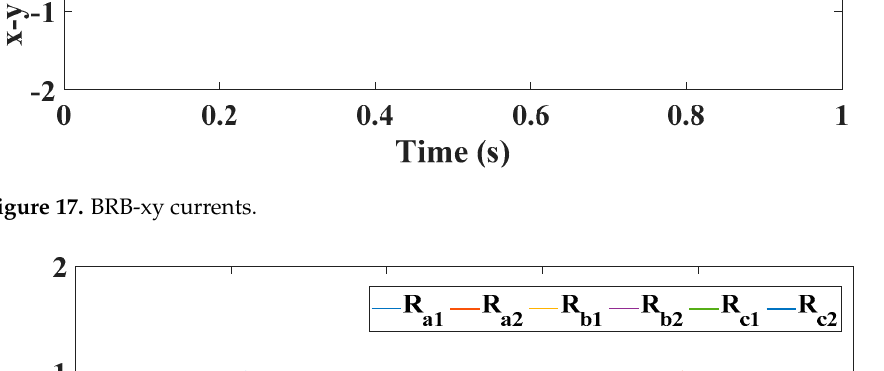
Figure 17. BRB-xy currents.